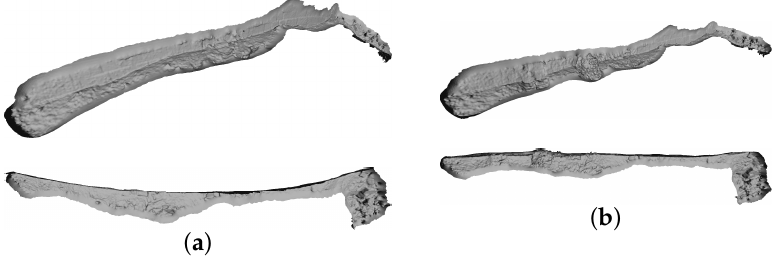
Figure 6. Sant Feliu dataset: slanted ( top row) and top views ( bottom row) of both the reconstruction obtained from pure optical data ( a ); and the reconstruction using the non-rigidly registered trajectory ( b ). Note how the unrealistic bending shown in the first is corrected in the second.